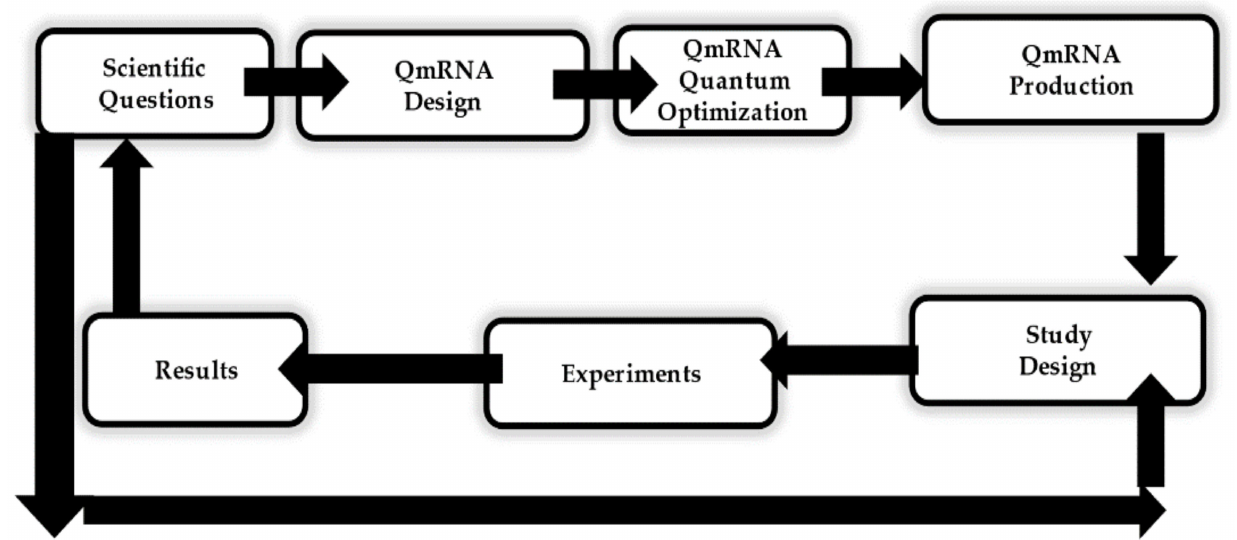
Figure 4. Research design quantumization: research